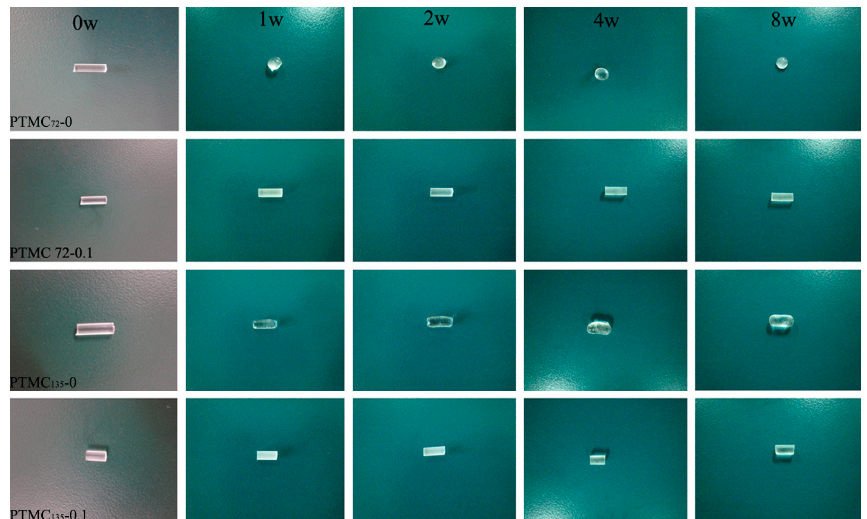
Figure 7. The macroscopic observation of the PTMC 72 -Ns and PTMC 135 -Ns at different times in 37 °C lipase solutions (0, 1, 2, 4, 8w represent before and after 1, 2, 4 and 8 weeks’ enzymatic degradation respectively).